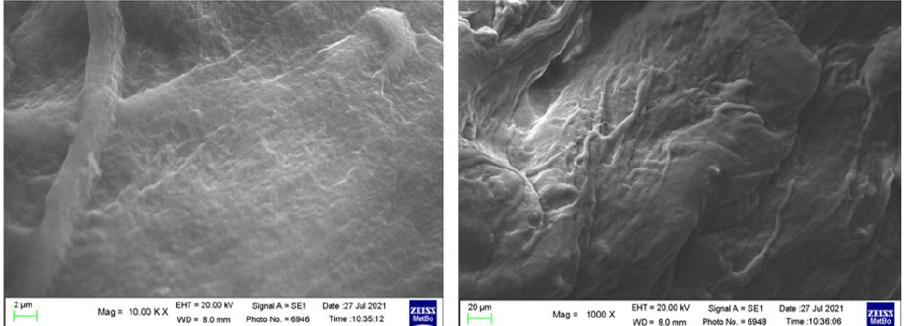
Figure A5. SEM images of crosslinked chitosan morphology at different magnification.